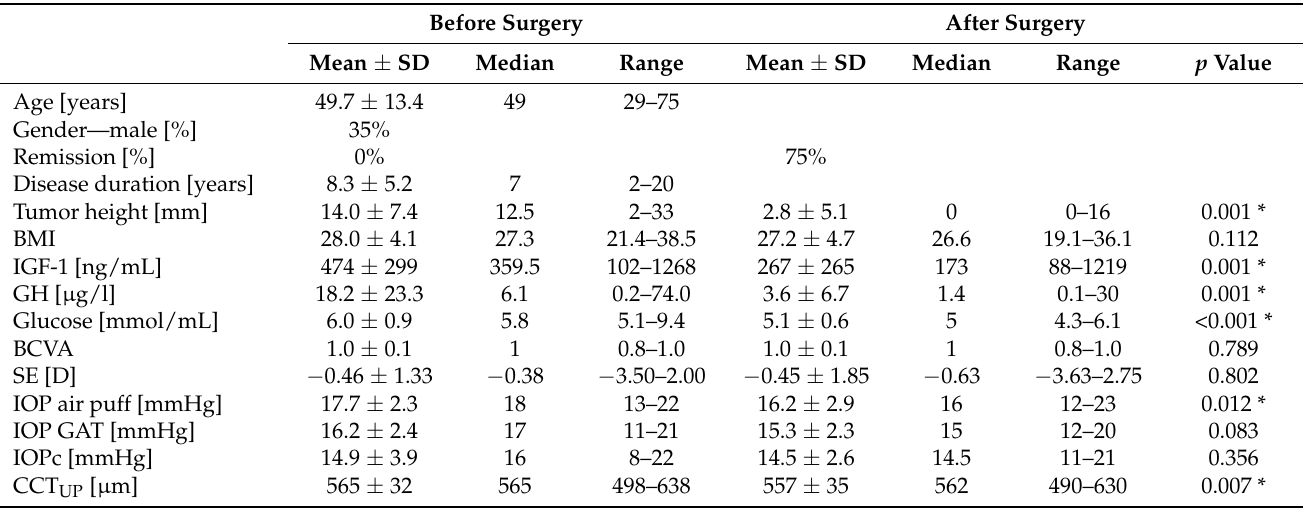
Table 1. Characteristics of the